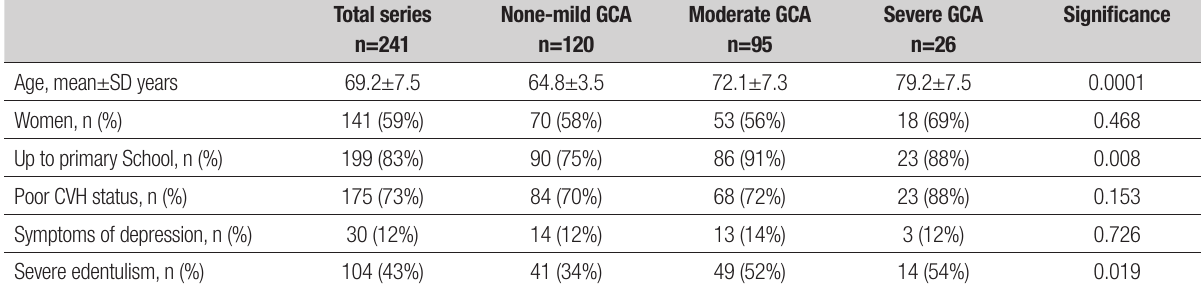
Table 2. Characteristics of community-dwelling elders living in Atahualpa according to severity of global cortical atrophy